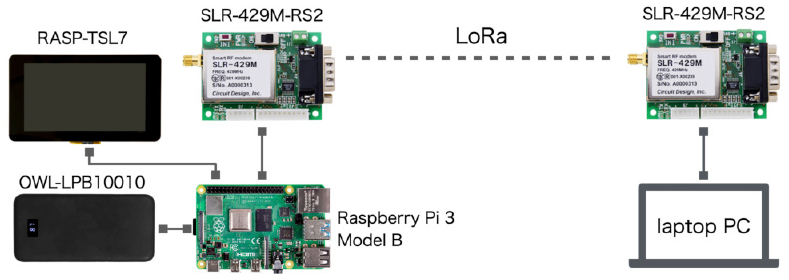
Figure 4. Long-range wireless communication system (LCS) connection